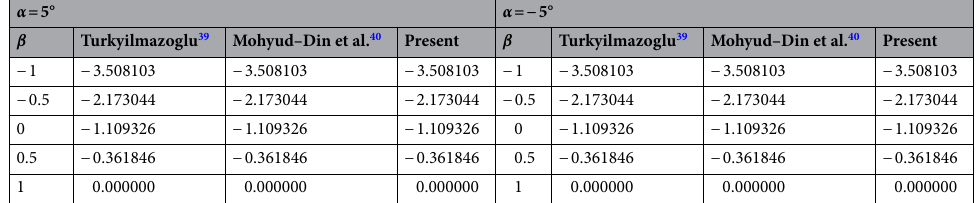
Table 2. f ′ ( 1 ) via α and β when Re